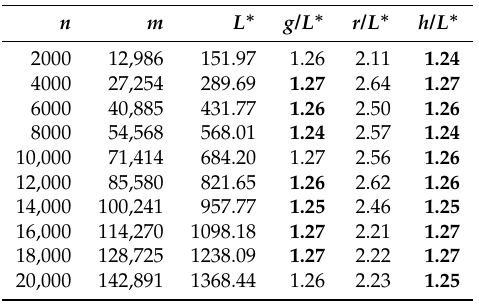
Table 4. Results for k-Planar Graphs where k = (cid:98) ln ( n ) (cid:99)